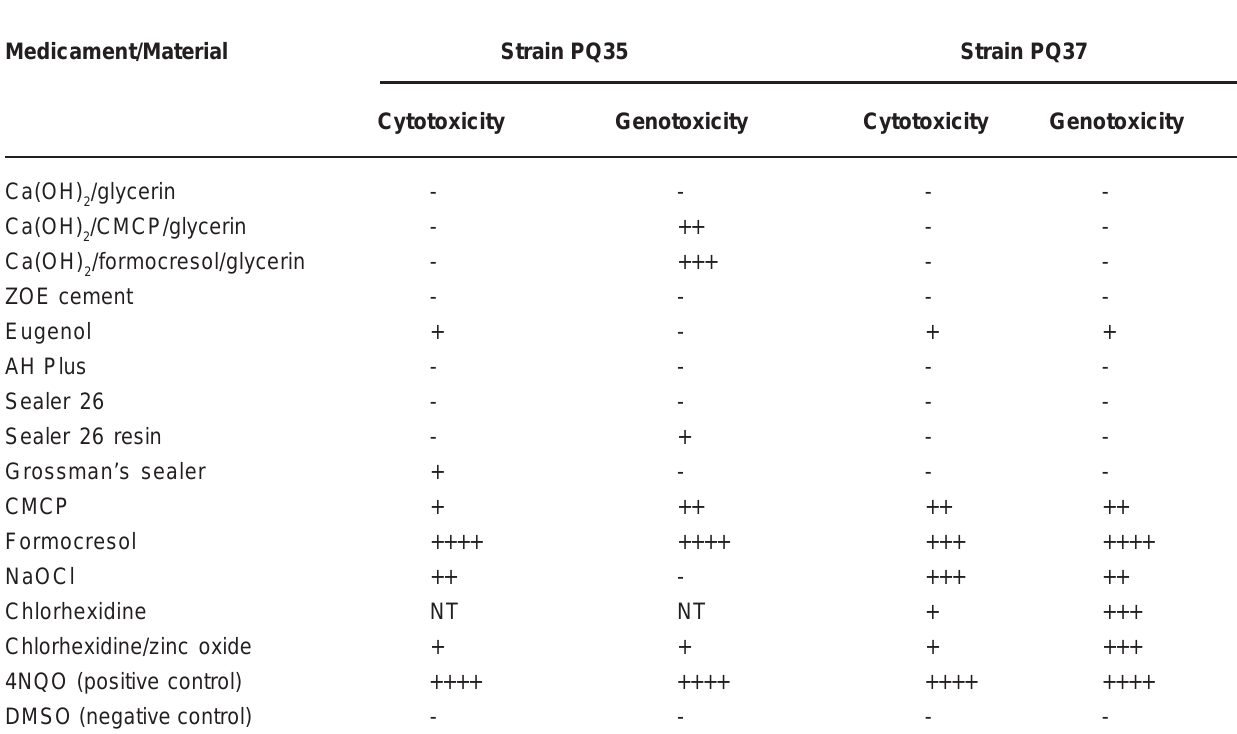
TABLE 1- Results of the SOS chromotest for evaluation of the cytotoxic and genotoxic potential of different endodontic substances and